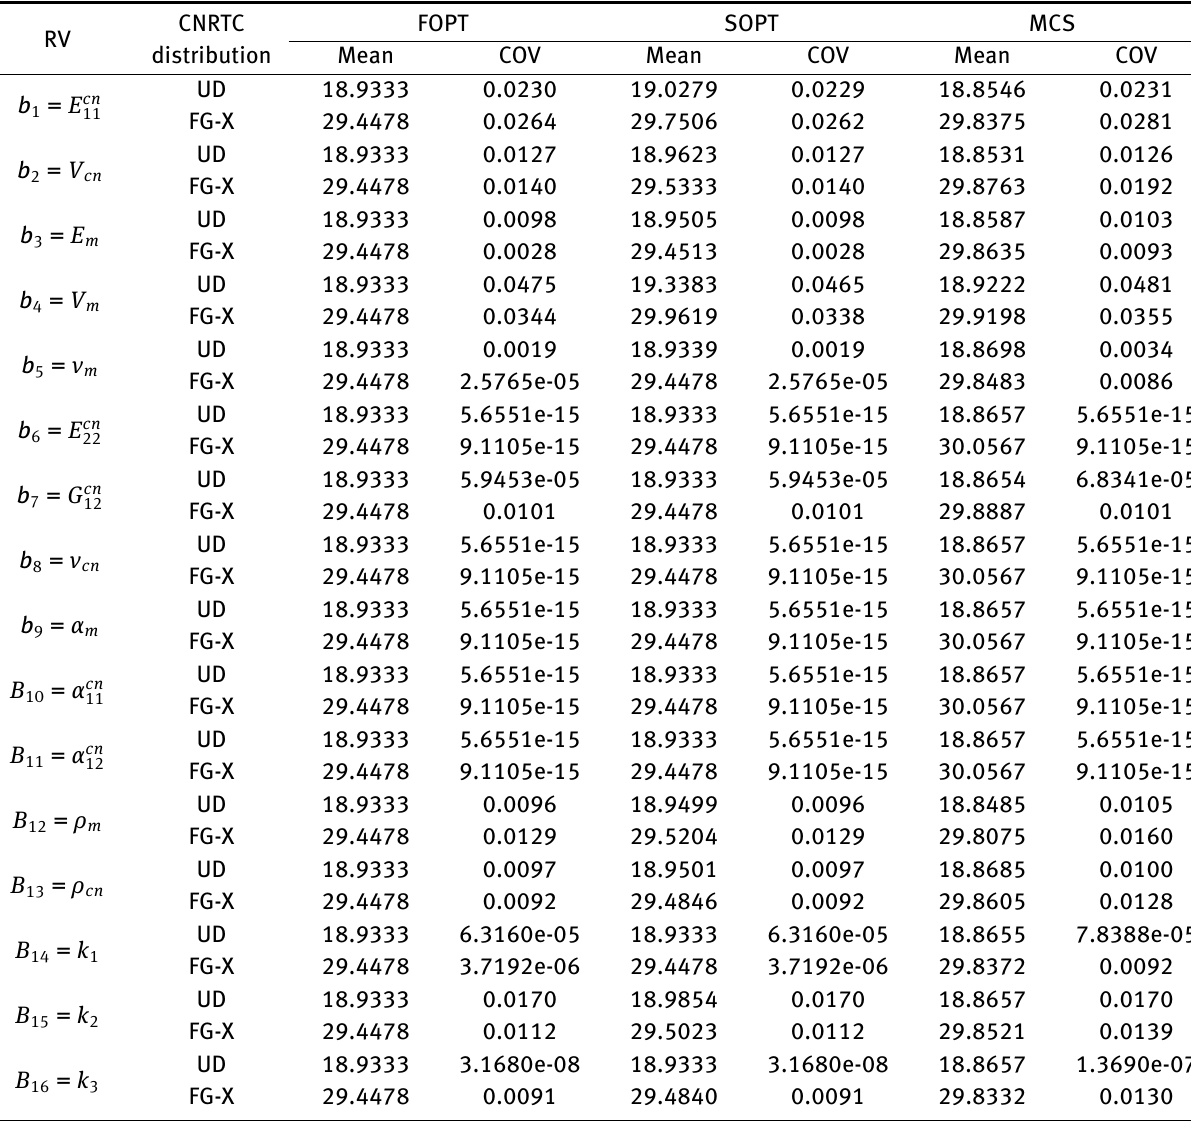
Table 6: Effects of individual random variables ( b i ) in case of UD and FG with random system properties { b i , ( i = 1, . . . , 16) = 0.1 } on the dimensionless mean and COV of nonlinear fundamental frequency of CNTRC beam with T = 500 K , V * cn = 0.17 , W max / h = 1.0 , a / h = 25 , k 1 = 10 4 , k 2 = 10 2 , k 3 = 10 3